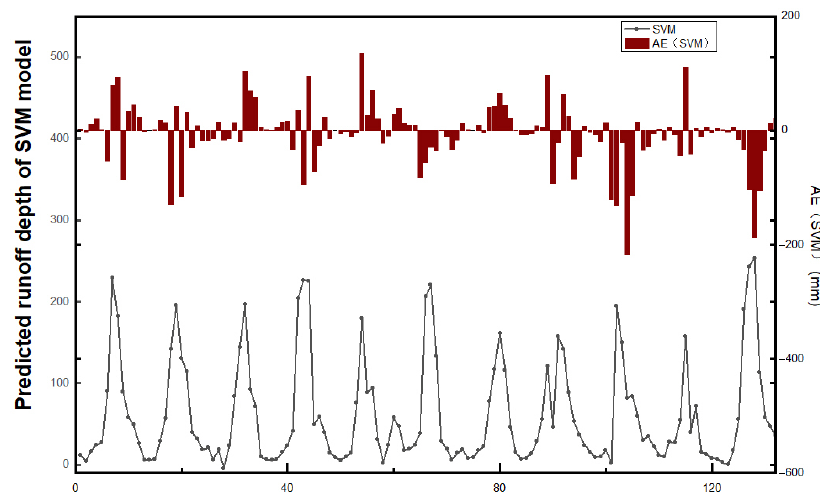
Figure 8. AE of SVM model.